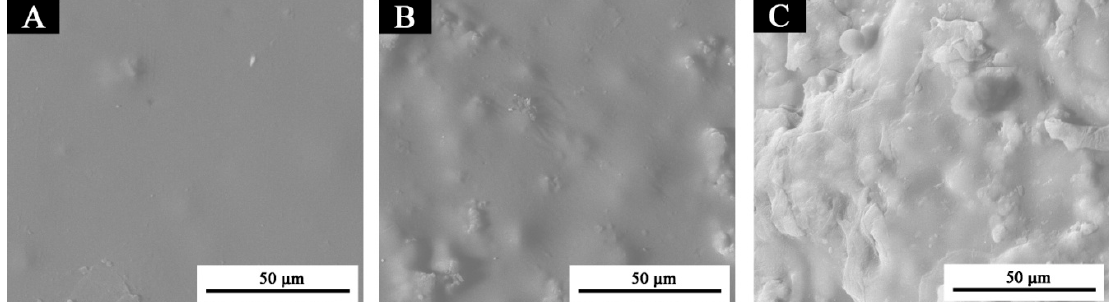
Figure 7. SEM image of paint film with different contents of microcapsules (the ratio of core materials to shell material in mass of 0.65). ( A ) 1.0% microcapsule addition, ( B ) 4.0% microcapsule addition, ( C ) 20.0% microcapsule addition.